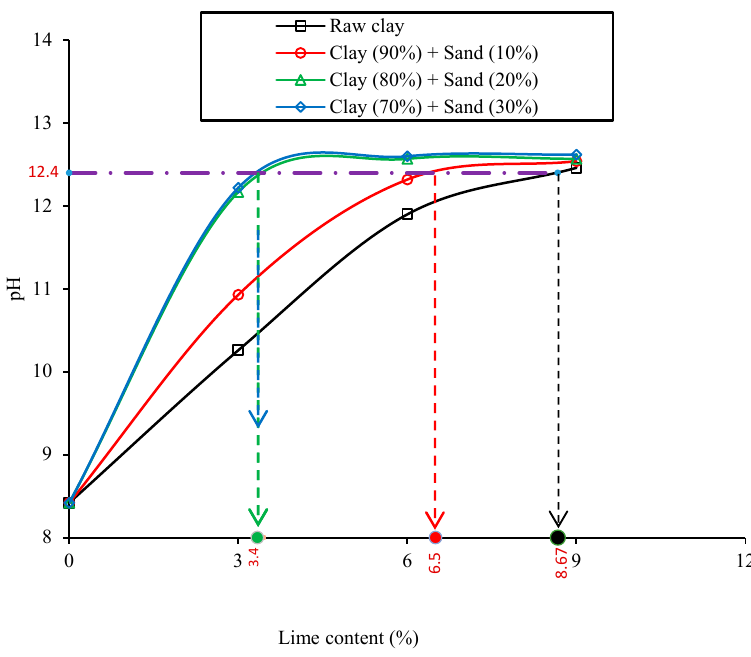
Figure 6. Determining lime demand.